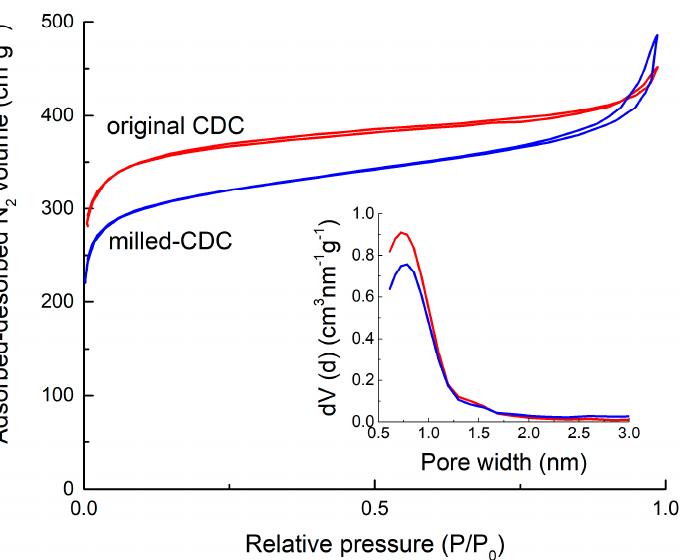
Table 1. Porosity characteristics of CDC.